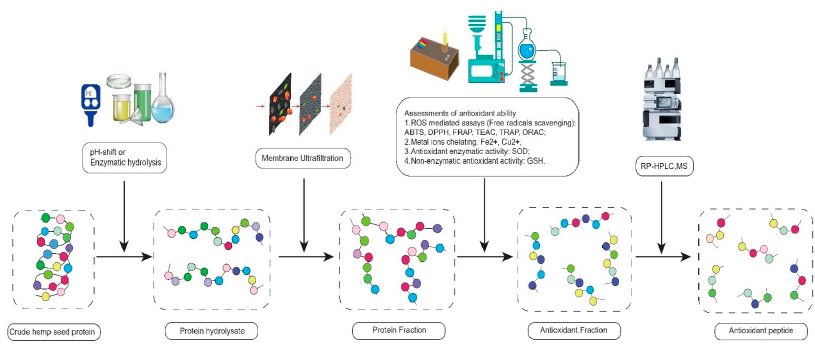
Figure 1. The experimental flow chart of isolation of antioxidant peptides.